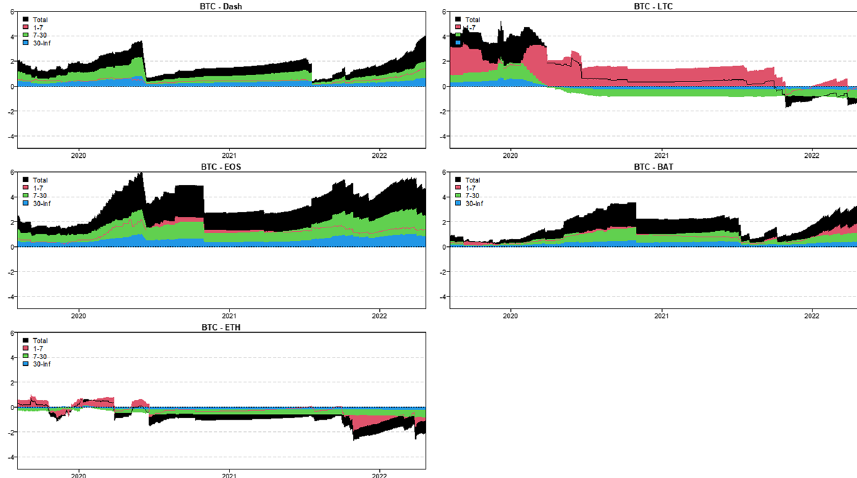
Fig. 30 Dynamic net-pairwise connectedness—realized hyperkurtosis (RHK)-BTC